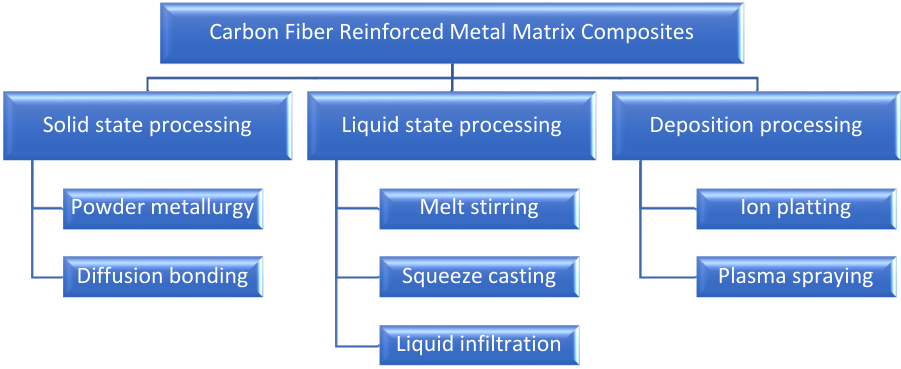
Figure 3. Processing methods for fabrication of CF/MMCs (adapted from [17]).